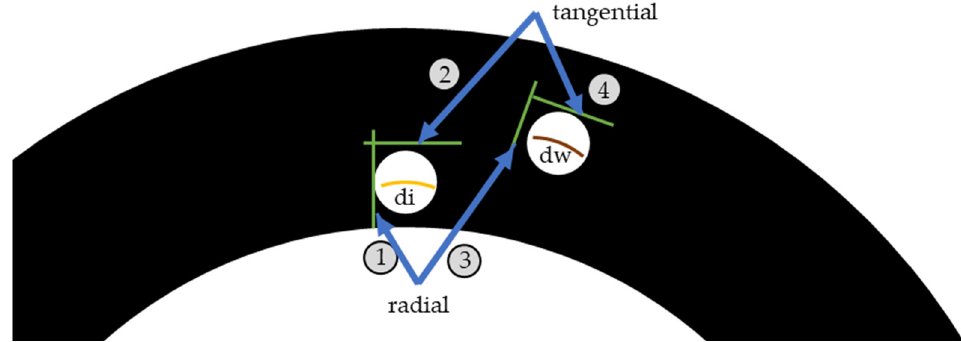
Figure 4. Definition of surface roughness measurement directions and diameters.